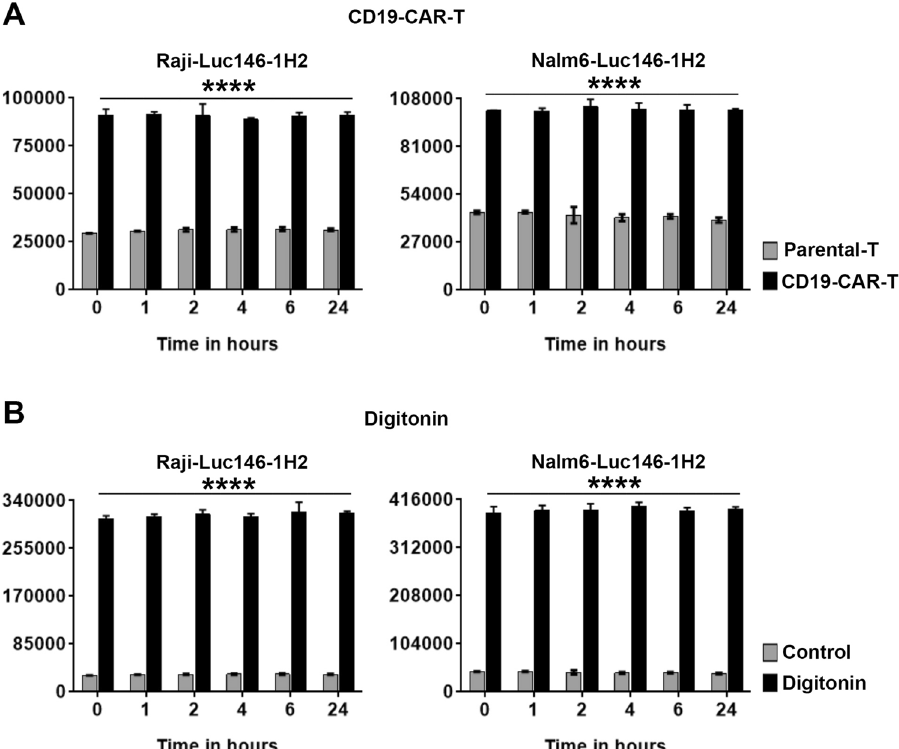
Figure 5. Luc146-1H2 is highly stable in cell culture medium. ( A ) Raji/Nalm6 cells stably expressing Luc146-1H2 were plated in a 24-well plate, co-cultured with parental-T cells or T cells expressing the CD19- CAR (CD19-CAR-T) at an Effector:Target (E:T) ratio of 1:1 for 18 h. After incubation, cell free supernatants were transferred into 6 different tubes and frozen immediately at − 80 °C. The tubes were directly transferred to 37 °C (from − 80 °C) and were incubated for indicated time periods (0–24 h). The luminescence was measured by adding D-luciferin containing assay buffer directly to each well. The values shown are mean ± SE of a representative experiment performed in duplicate for at least three times. ( B ) Raji/Nalm6 cells stably expressing Luc146-1H2 were plated in a 24-well plate, treated with media alone (control) or digitonin (30 μg/ml) for 90 min. After incubation, cell free supernatants were transferred into 6 different tubes and assayed as described above for ( A ). The values shown are mean ± SE of a representative experiment performed in duplicate for at least three times. Statistically significant differences are shown by asterisks (****) at a level of P <